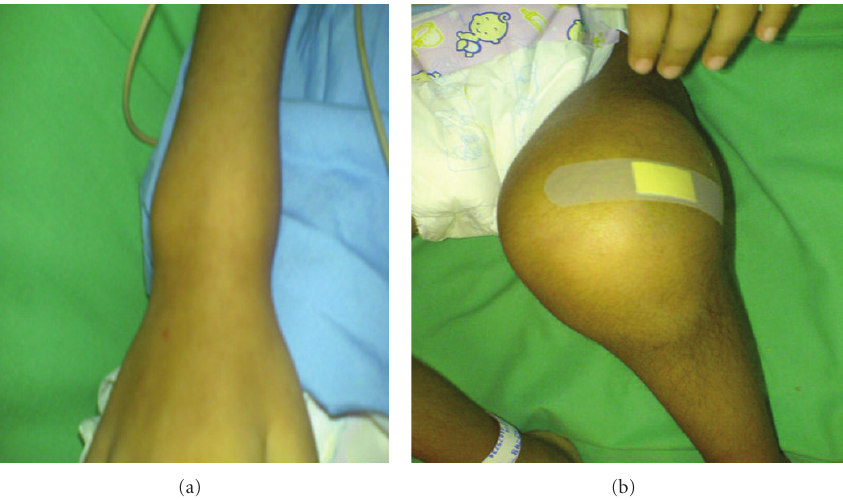
Figure 1: Clinical photographs showing swelling of the right wrist (a) and left knee (b).